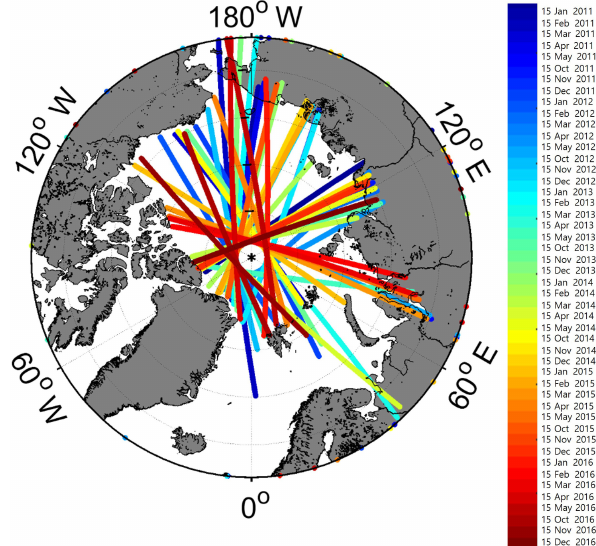
Figure 2. The 48 CryoSat-2 orbit files from January 2011 to December 2016 used for extraction endmember waveforms. The CryoSat-2 orbit files almost cover the entire Arctic